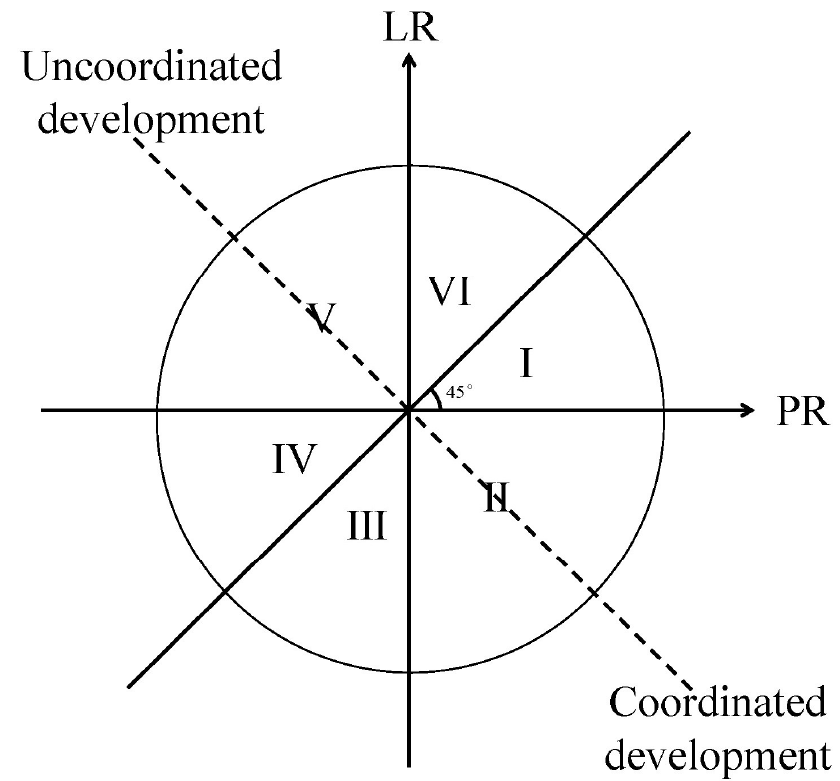
Figure 3. The classification of different coupling relationship types.